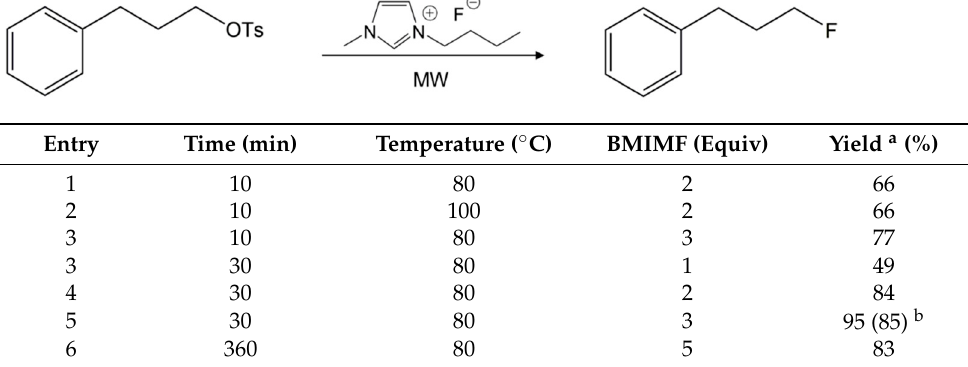
Figure 1. Calculated transition state for S N 2 fluorination using CsF facilitated by [bmim][OMs].